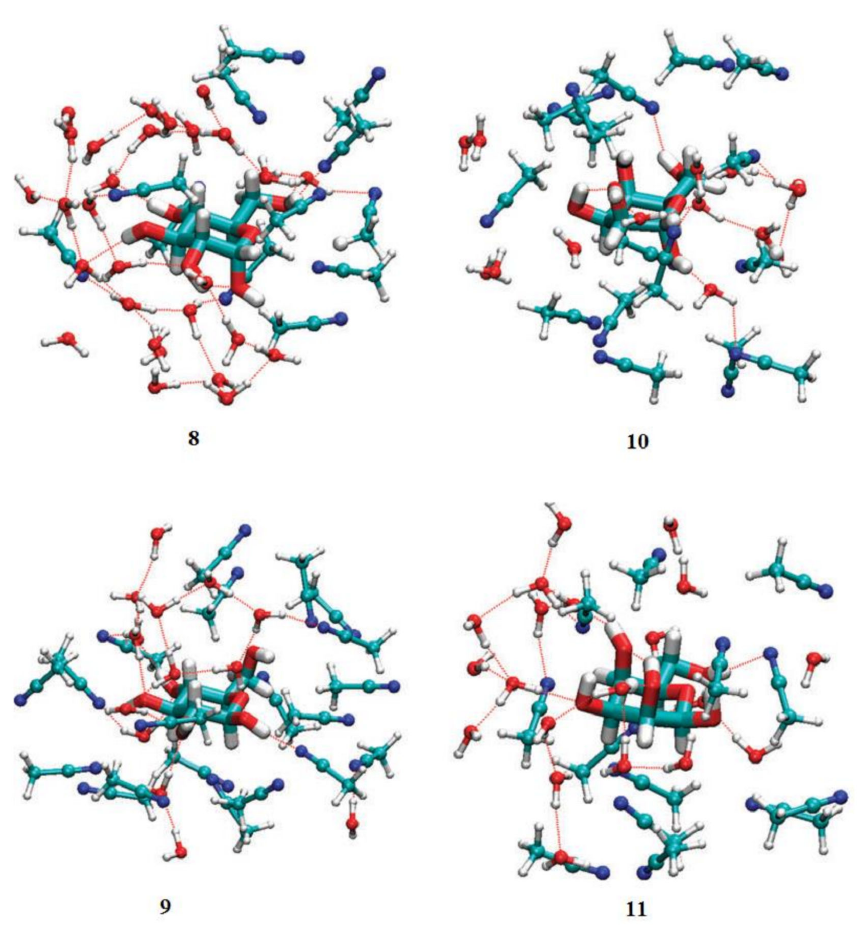
Figure 15. Snapshots of the solvation shell of four sugars obtained from the MD runs: α -glucose ( 8 ), β -glucose ( 9 ), α -talose ( 10 ), and β -talose ( 11 ). Reproduced with minor editing privilege from Bagno and Saielli [115] with the permission of the Royal Society of Chemistry.